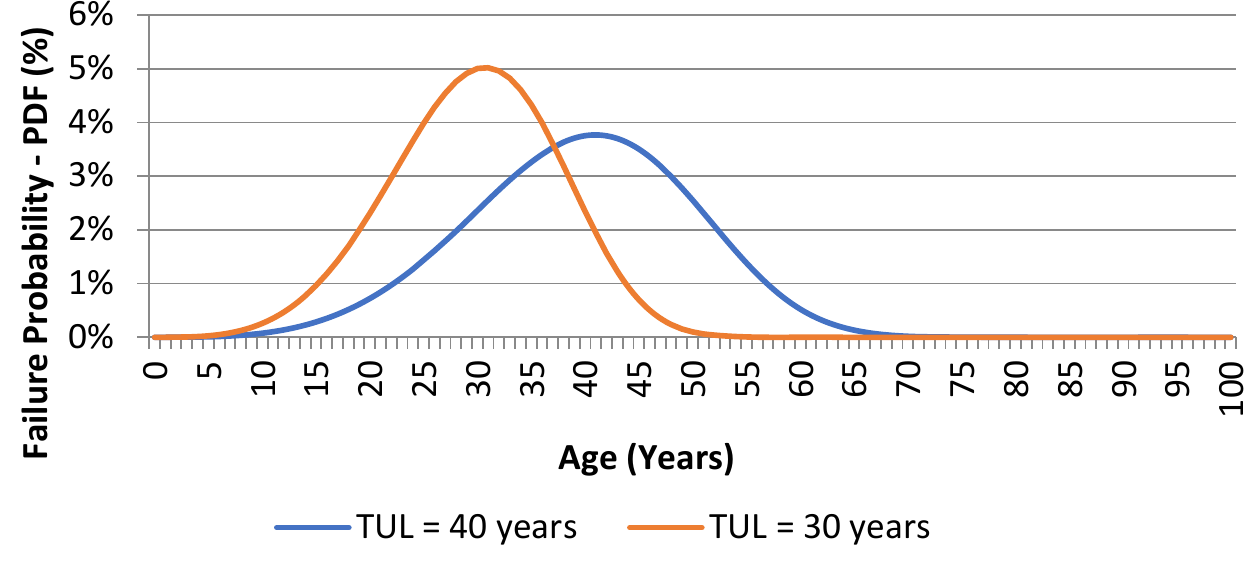
Figure 12. PDF curves for TRXLPE cable direct-buried (TUL = 30 years) and installed in duct (TUL = 40 years).